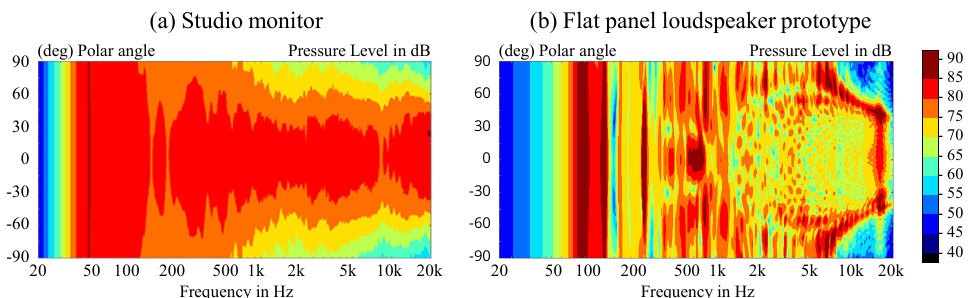
Figure 1. Polar angle-dependent radiation of a studio monitor in comparison to a flat panel loud- speaker prototype measured in 2m distance with a 2° angular resolution. Both measurements were referenced to the same averaged SPL value of 80dB in the frequency range from 100Hz to 1000Hz.